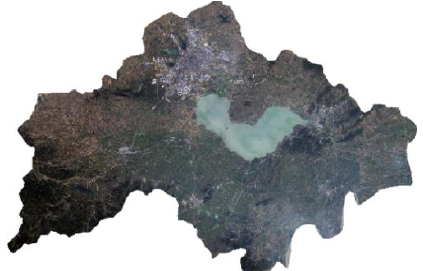
Figure 2 2015 Satellite imagery of Chaohu Lake